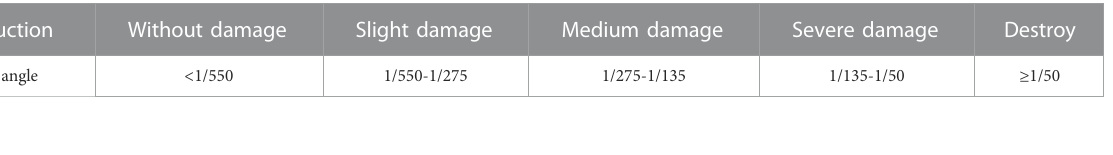
TABLE 12 Maximum displacement of isolated